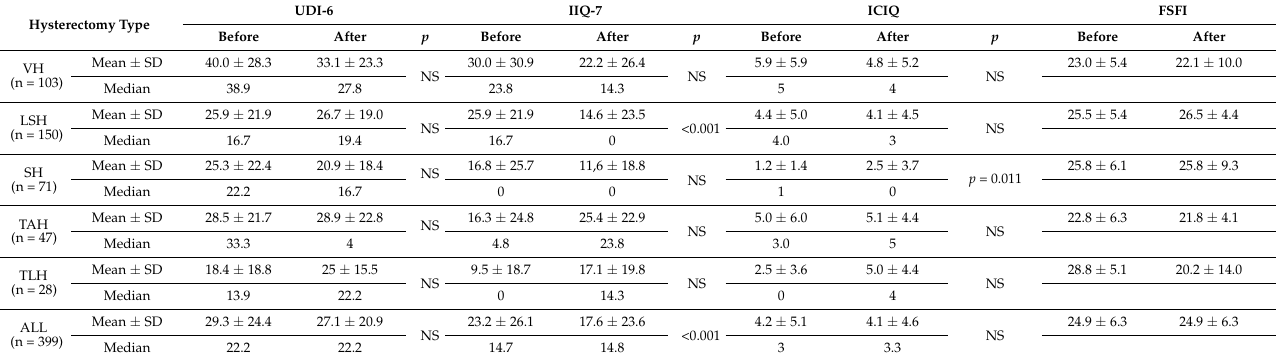
Table 2. Urogenital Distress Inventory-6 (UDI-6), Incontinence Impact Questionnaire-7 (IIQ-7), The International Consulta- tion on Incontinence Questionnaire (ICIQ) and the Female Sexual Function Index (FSFI) scores among the study group patients before and after